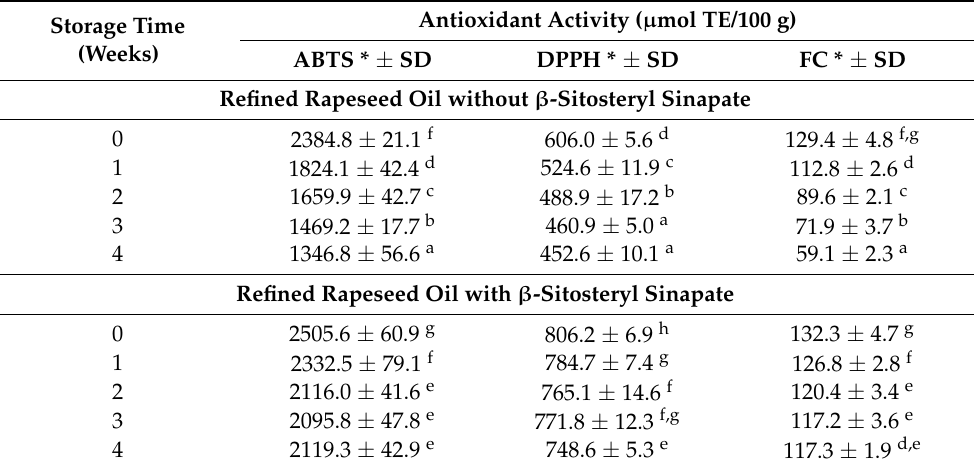
Table 2. Antioxidant activity of rapeseed oils without ant with β -sitosteryl sinapate stored under accelerated